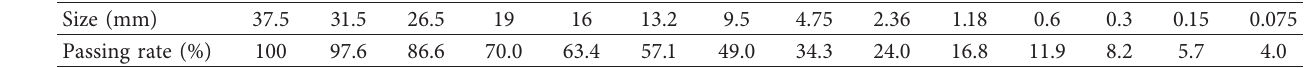
Table 1: Aggregate gradation for LSAM-30.